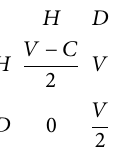
FiGURE 1 Numerical solution of Eq. 6 when ? = 3, ? = 7.